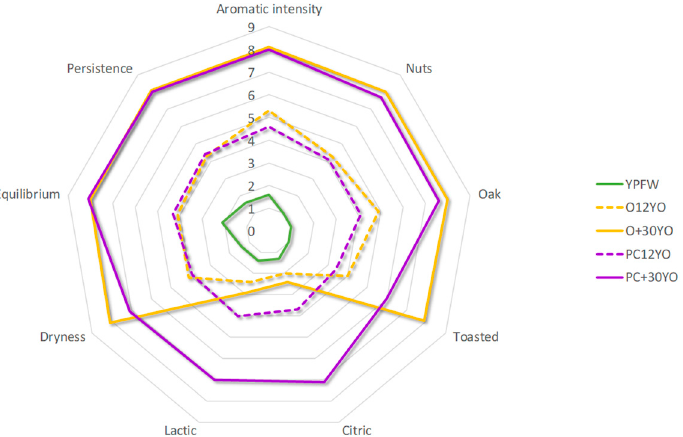
Figure 3. Spider-web graph showing the average sensory scores granted by the tasting panel to the evaluated wines.